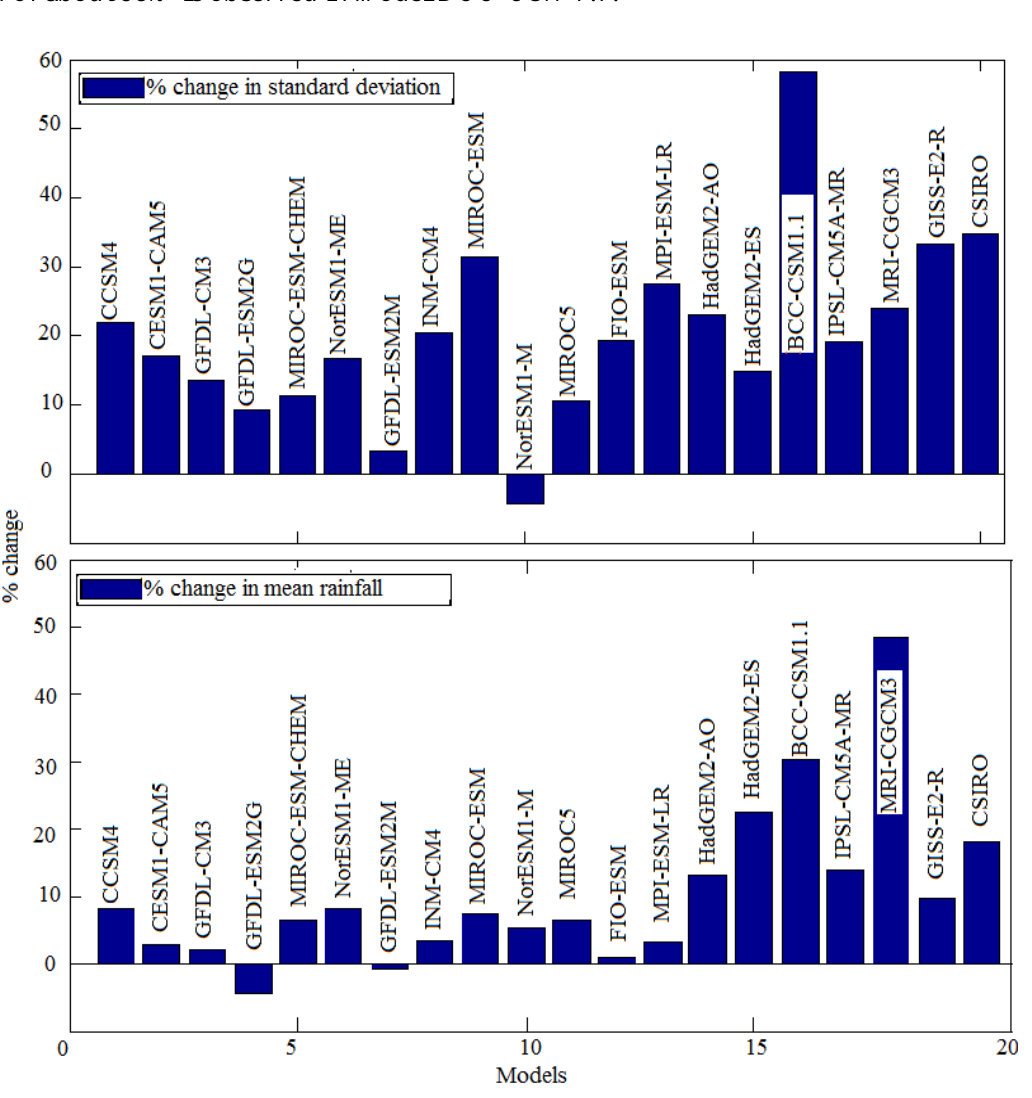
Figure 8. Percentage changes in mean and standard deviation of